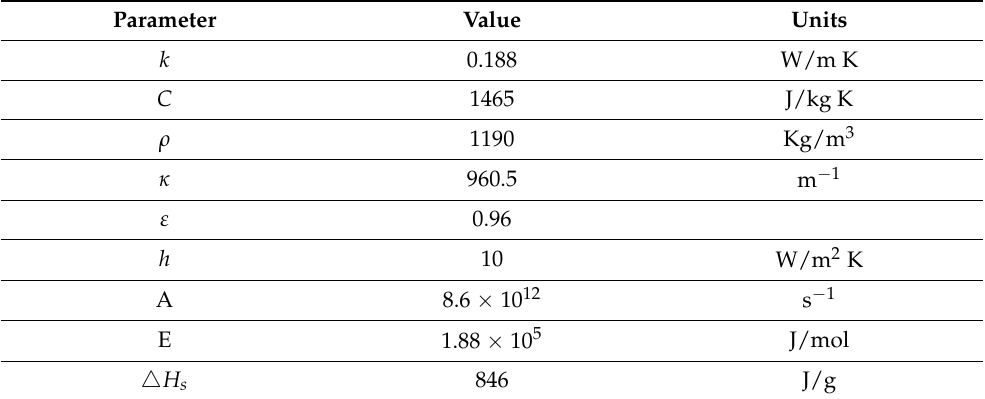
Table 1. Thermophysical properties for the PMMA materials.